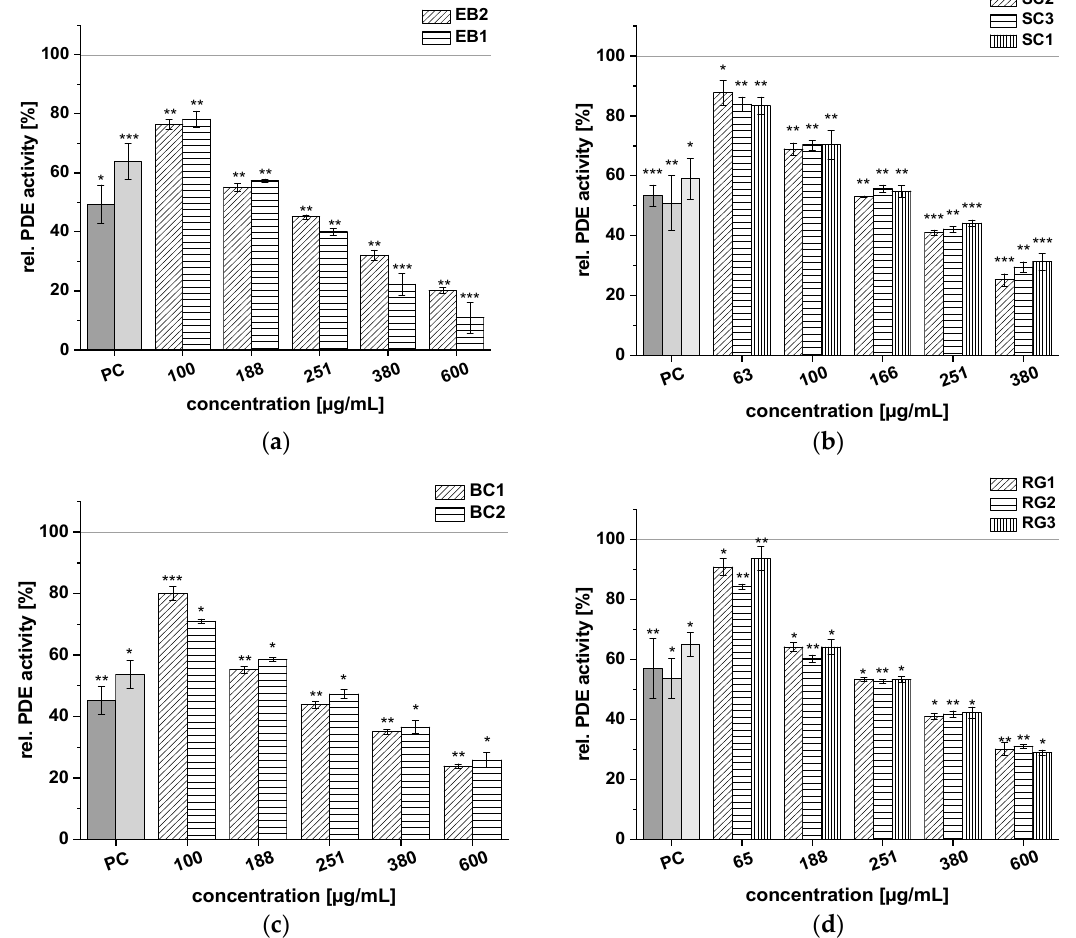
Figure 4. Results for tests of cAMP-specific phosphodiesterase (PDE) activity after incubation with elderberry (EB1, EB2) ( a ), sour cherry (SC1, SC2, SC3) ( b ), black currant (BC1, BC2) ( c ), and red grape (RG1, RG2, RG3) ( d) extracts. Positive control (PC) was caffeine (1.21 mM). Data are expressed as relative (rel.) PDE activity (in percentage of solvent control) as mean ± standard deviation of three or four independent experiments. The significance of differences between sample and solvent control (100%) was assessed using Student’s t -test. * p < 0.05; ** p < 0.01; *** p < 0.001.